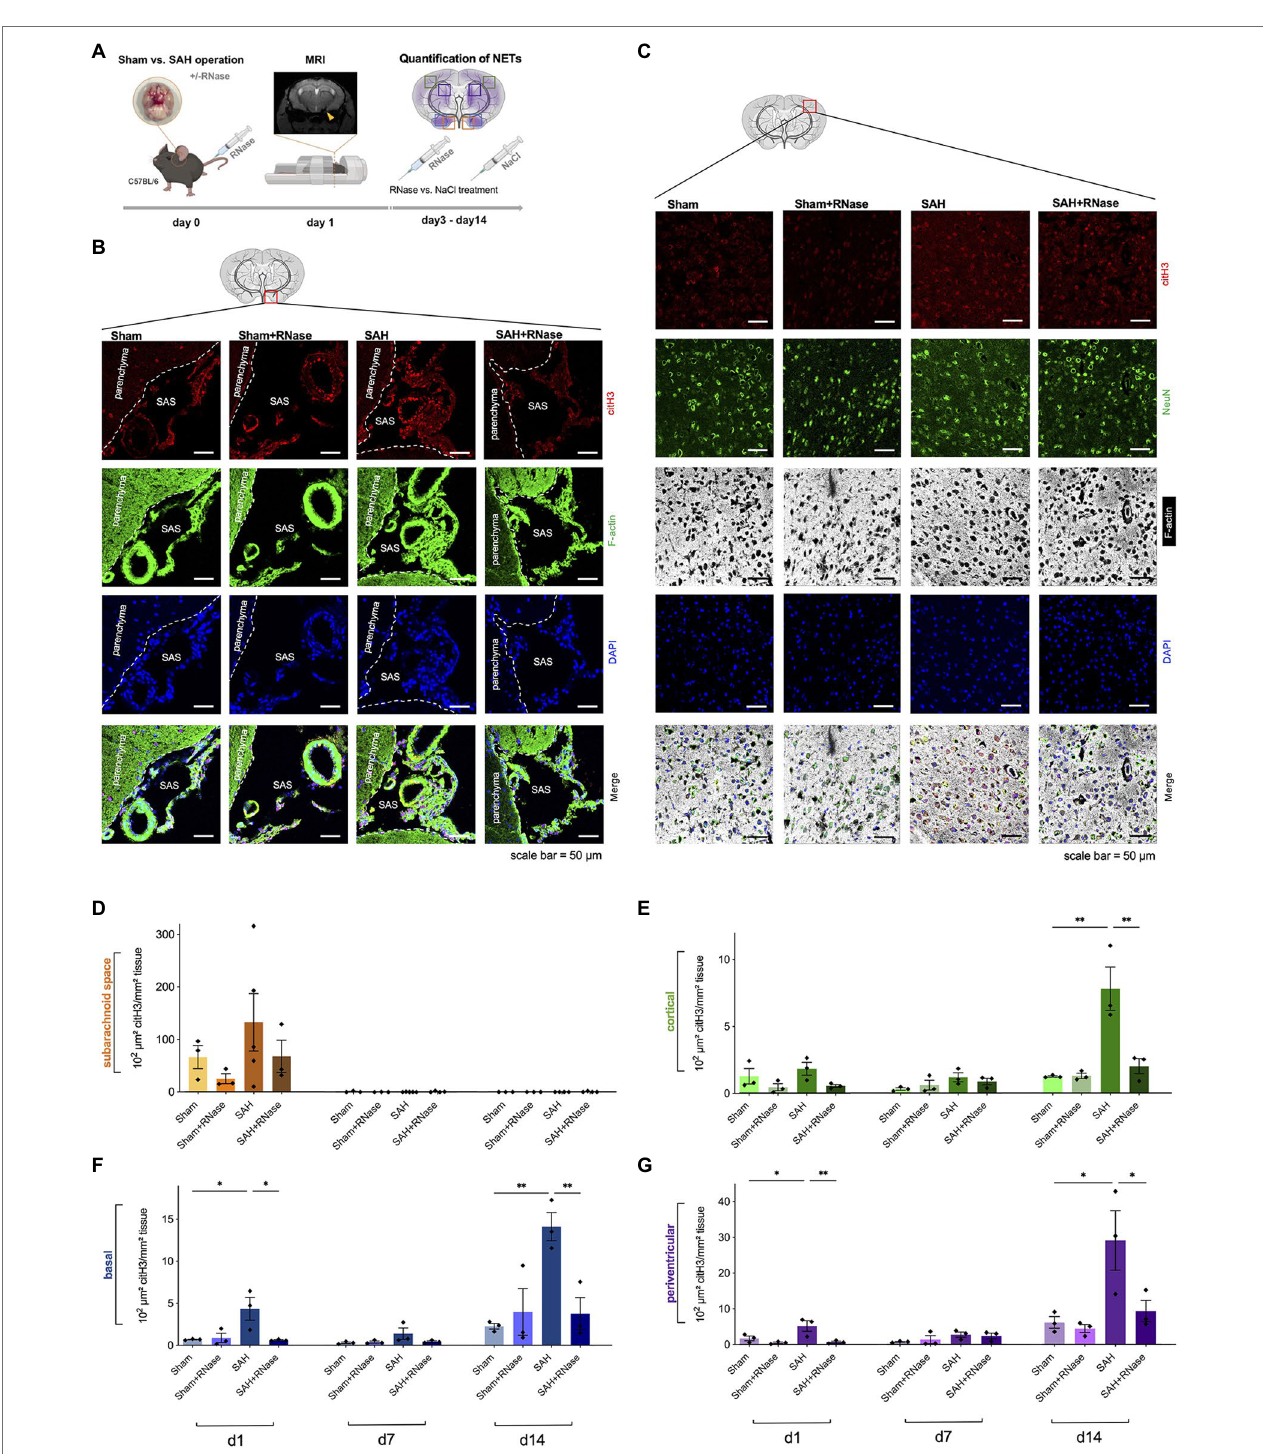
FIGURE 2 | RNase A treatment reduces accumulation of NETs. (A) Experimental setup for RNase treatment: during operative induction of SAH, mice were treated with RNase A (42 μ g/kg body weight) or sodium chloride (NaCl) as a control condition, and MRI to confirm bleeding. RNase A treatment was repeated every 3 days. (B) Representative images of triple immunofluorescence staining with citH3, F-actin, and DAPI subarachnoid space of the four subgroups (Sham, n = 3; Sham + RNase, n = 3; SAH, n = 3; and SAH + RNase, n = 3) on day 1, scale bar = 50 μ m. (C) Representative images of quadruple immunofluorescence staining with citH3, NeuN, F-actin, and DAPI of the corresponding four subgroups in cortical area on day 14, scale bar = 50 μ m. (D–G) Quantification of NETs after RNase A treatment in relation to localization (subarachnoid space, basal, cortical, and periventricular parenchyma) and time course (day 1, 7, and 14). SAS, subarachnoid space. * p < 0.05 and ** p <